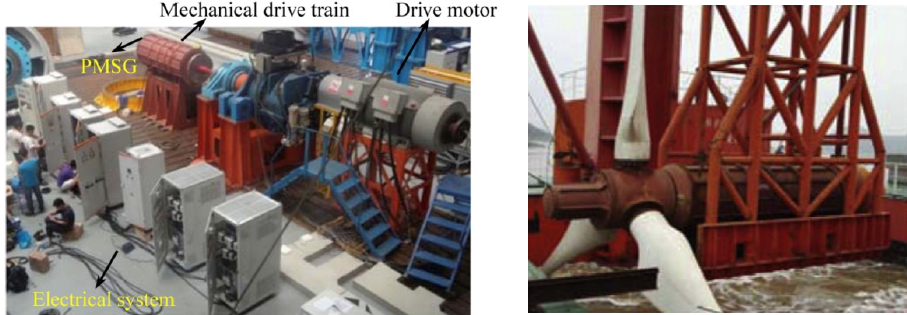
Figure 21. A 120 kW horizontal-axis semi-direct-drive hydraulic variable-pitch generator set. Re- produced from [60], Elsevier.